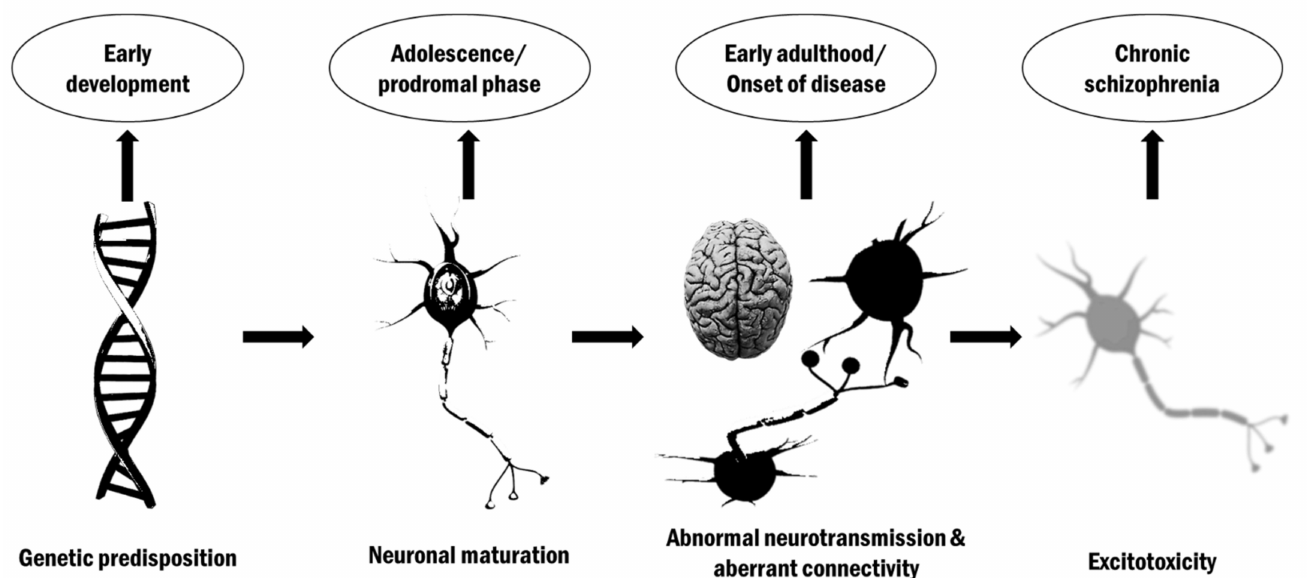
Figure 4. Integral etiological model of